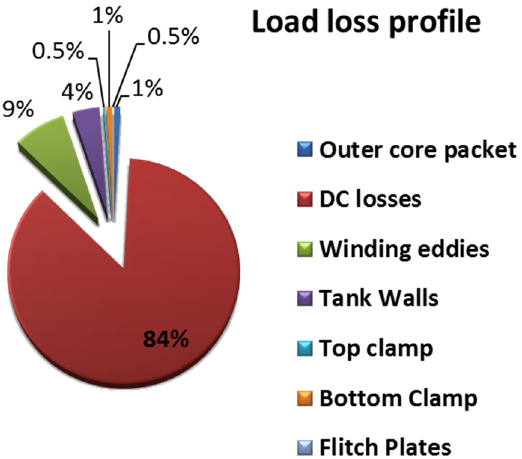
Figure 4. Transformer stray load loss components.